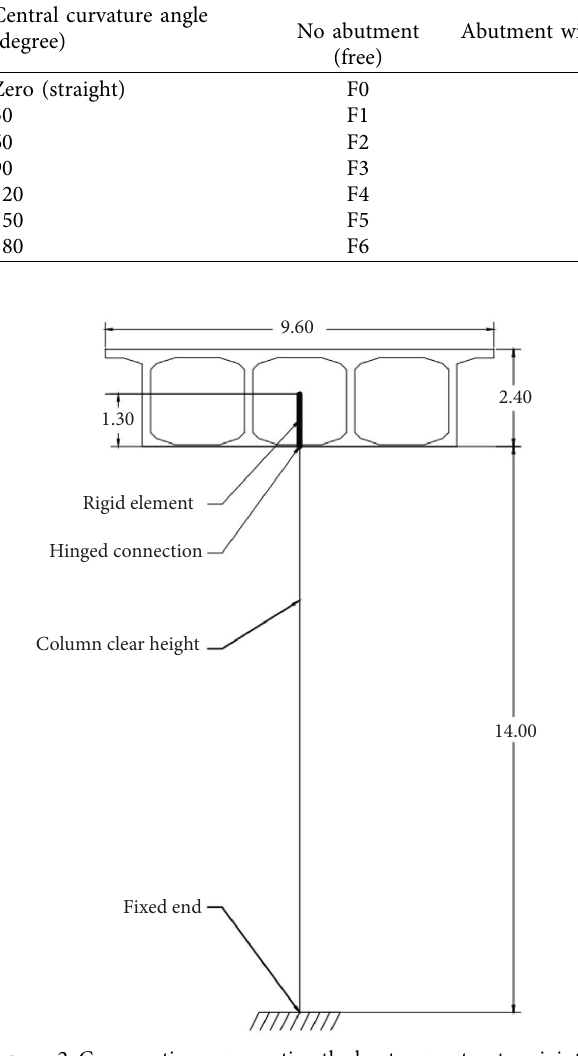
Figure 2: Cross section representing the bent-superstructure